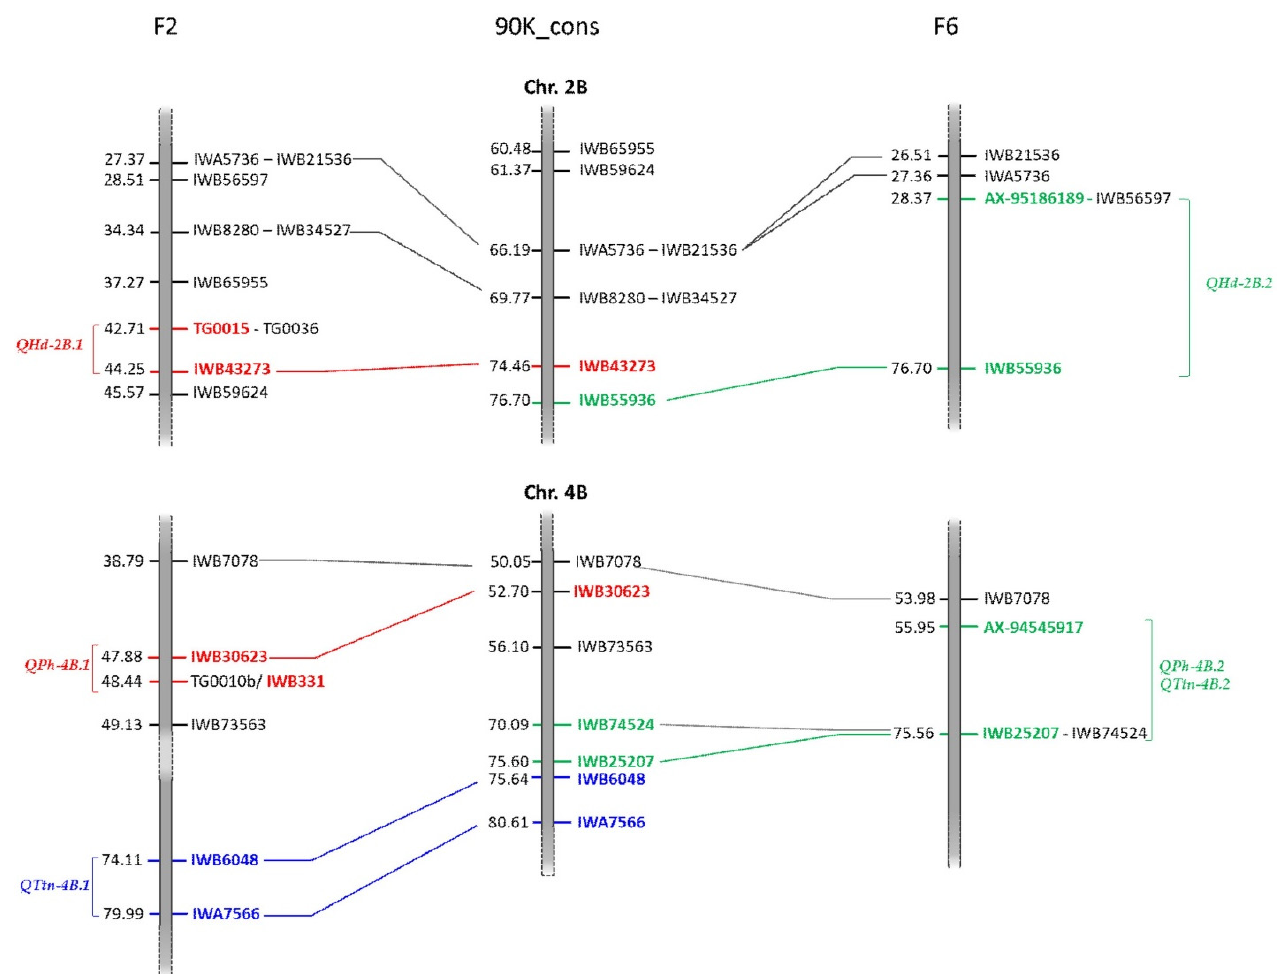
Figure 3. A graphical representation of the 2B and 4B linkage groups derived from the F 2 and F 6 maps and their comparison with the 90K consensus map. The distance between markers is in centimorgans (cM). The markers flanking the QTLs are colored in red ( QHd-2B.1 and QPh-4B.1 ) and blue ( QTtn-4B.1 ) in F 2 , while in green for the QTLs ( QHd-2B.2 , QPh-4B.2, and QTtn-4B.2 ) in F 6 . Solid lines connect the genetic loci in common between the F 2 and F 6 genetic maps and the 90K consensus map [60].